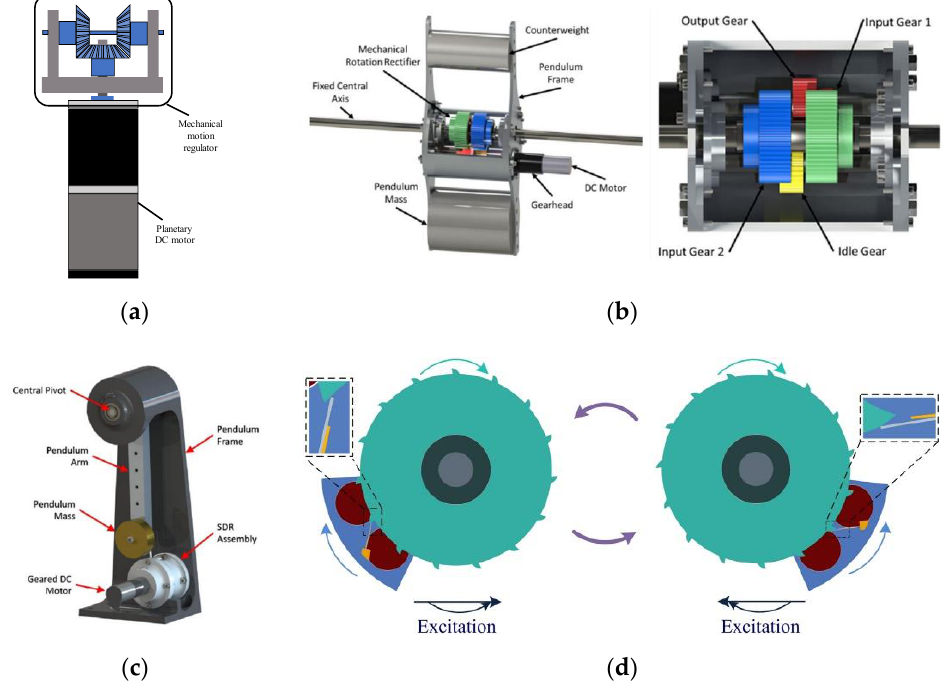
Figure 7. Mechanical motion rectifiers based on ( a ) a Bevel gear [64]; ( b ) offset gearing [65]; ( c ) a string-driven rectifier [66]; and ( d ) a pendulum-plucked rotor [67]. Reprinted with permission from Ref. [67]. Copyright 2021, Elsevier.